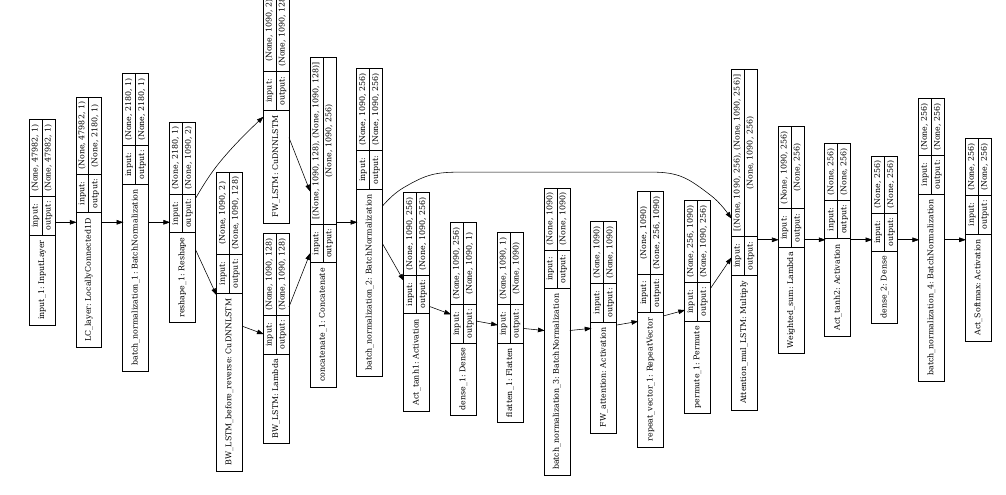
Figure 26: Network for synchronized AT128-N.